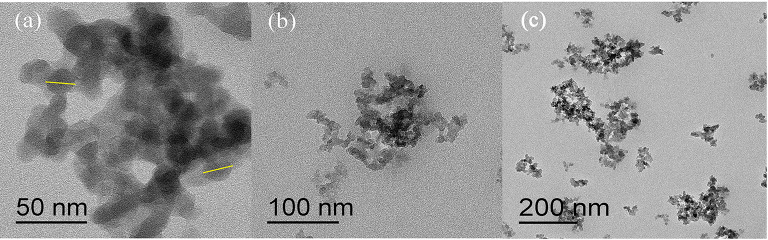
TEM image of responsive nano-SiO2. The scale bars in (a–c) are 50, 100, and 200 nm, respectively.